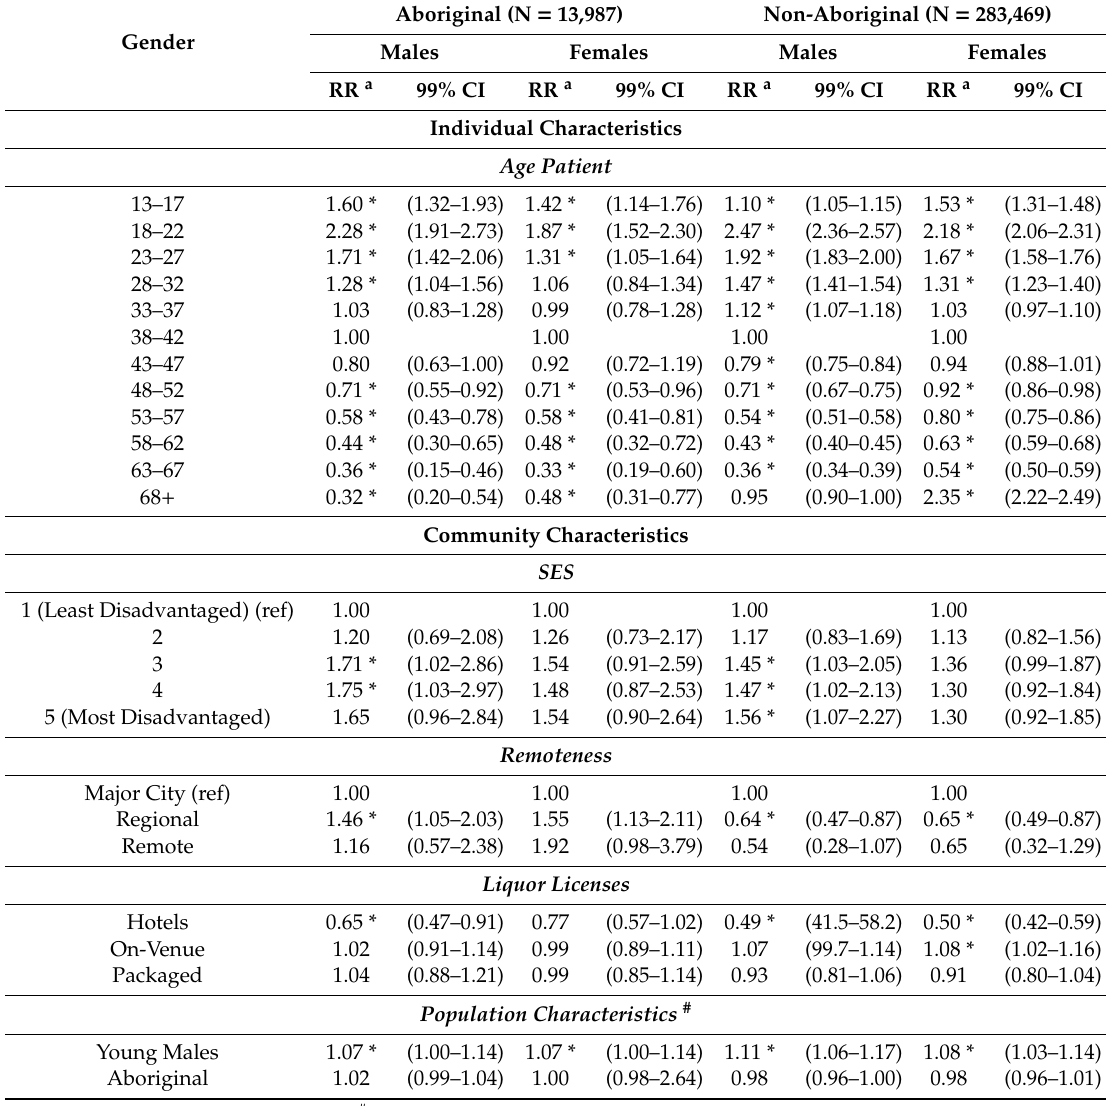
Table 2. Adjusted rate ratios for multi-level Poisson regression model of alcohol-related injuries among Aboriginal and non-Aboriginal persons in